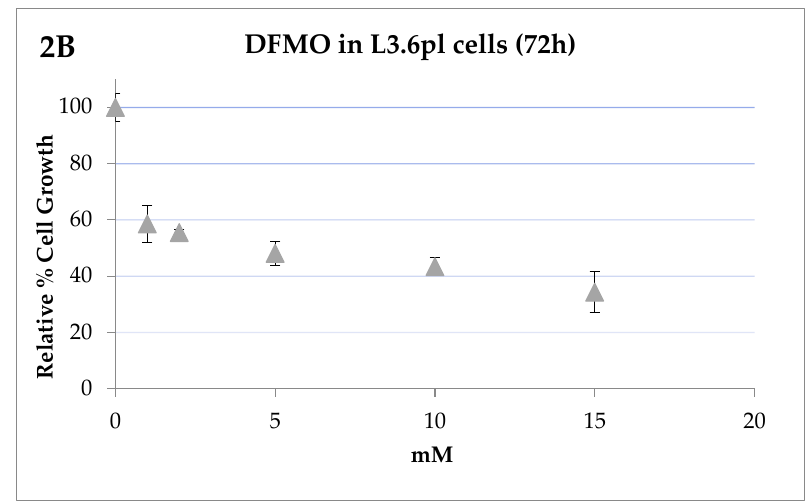
Figure 2. Influence of trans-4-methylcyclohexylamine (MCHA), N -cyclohexyl-1,3-propanediamine (CDAP), polyamine transport inhibitor (PTI, trimer 44), and difluoromethylornithine (DFMO) on L3.6pl human pancreatic cancer cell growth. Panel A: Growth inhibition by MCHA, CDAP, and the trimer44 PTI in L3.6pl cells after 72 h incubation at 37 °C in a 5% CO 2 atmosphere. The 72 h IC 50 values of MCHA, CDAP, and trimer44 PTI in L3.6pl human pancreatic cancer cells were 1000 ± 4.4 µM, 941 ± 12.1 µM, and 69.6 ± 1.8 µM, respectively. In general, the PTI was well tolerated at low doses (e.g., 4 µM with no reduction in growth) and the other inhibitors could be dosed at high concentrations with little effect on cell growth. For example, after 72 h, MCHA and CDAP at 100 µM gave 91% and 99% relative growth, respectively, versus the untreated control. Panel B: Relative cell growth in the presence of DFMO in L3.6pl cells after 72 h incubation at 37 °C in a 5% CO 2 atmosphere. The 72 h IC 50 value of DFMO in L3.6pl cells was 4.24 ± 0.11 mM.